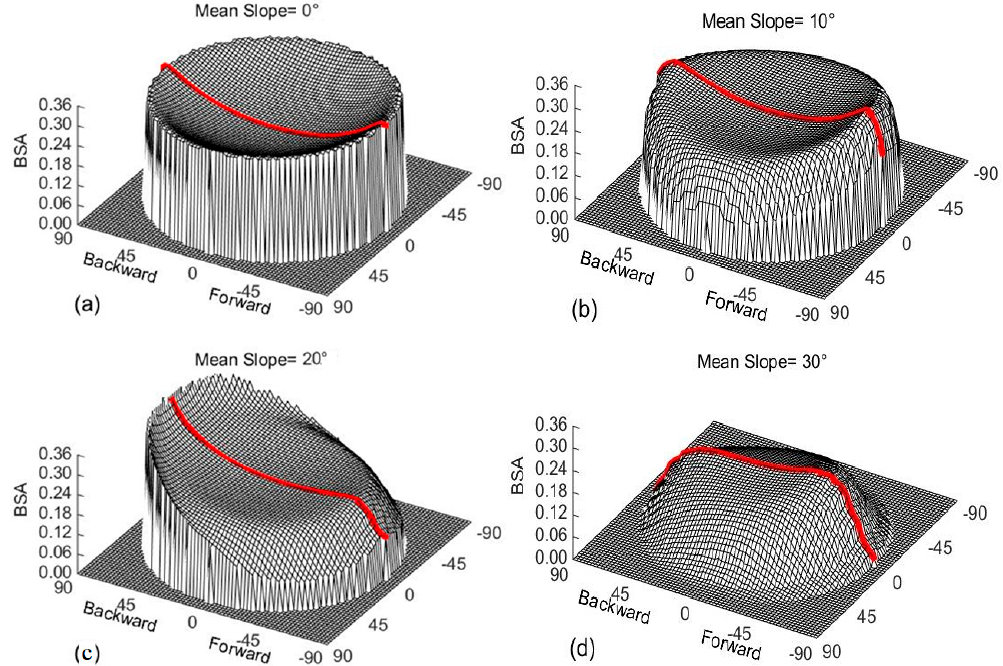
Figure 6. Hemispheric distribution of BSA under different SZAs and real 1-km DEMs: ( a ) flat terrain; ( b ) dem-10-1; ( c ) dem-20-1; and ( d ) dem-30-1. The radial coordinate is the SZA, and the angular coordinate is the SAA. The red line represents the north-south line; the backward side represents the northern aspect (i.e., where SAA is equal to 0°), and the forward side represents the southern aspect (i.e., where SAA is equal to 180°).